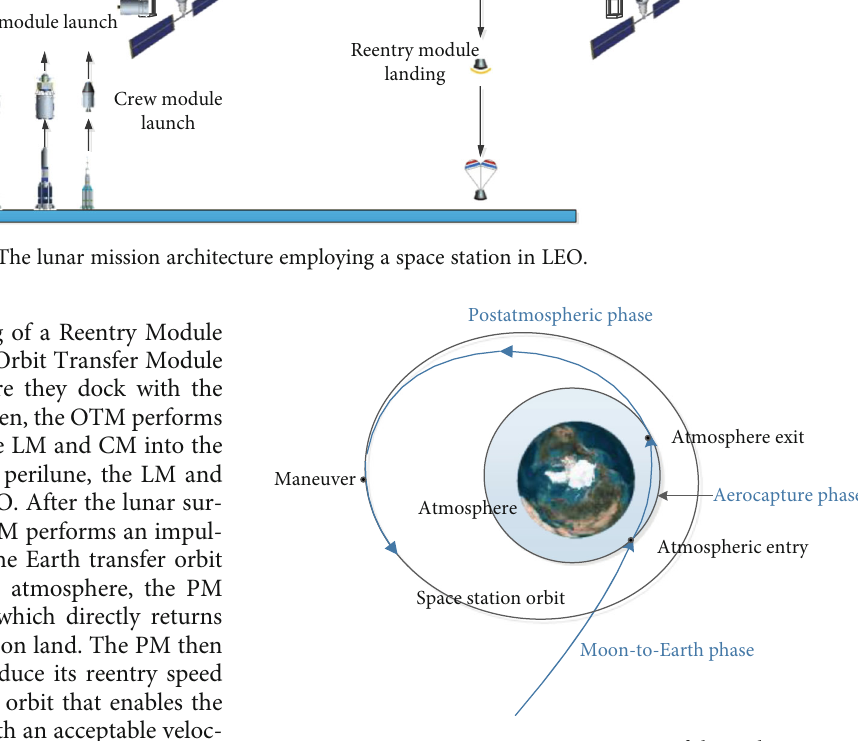
Figure 2: Entire trajectory consisting of three